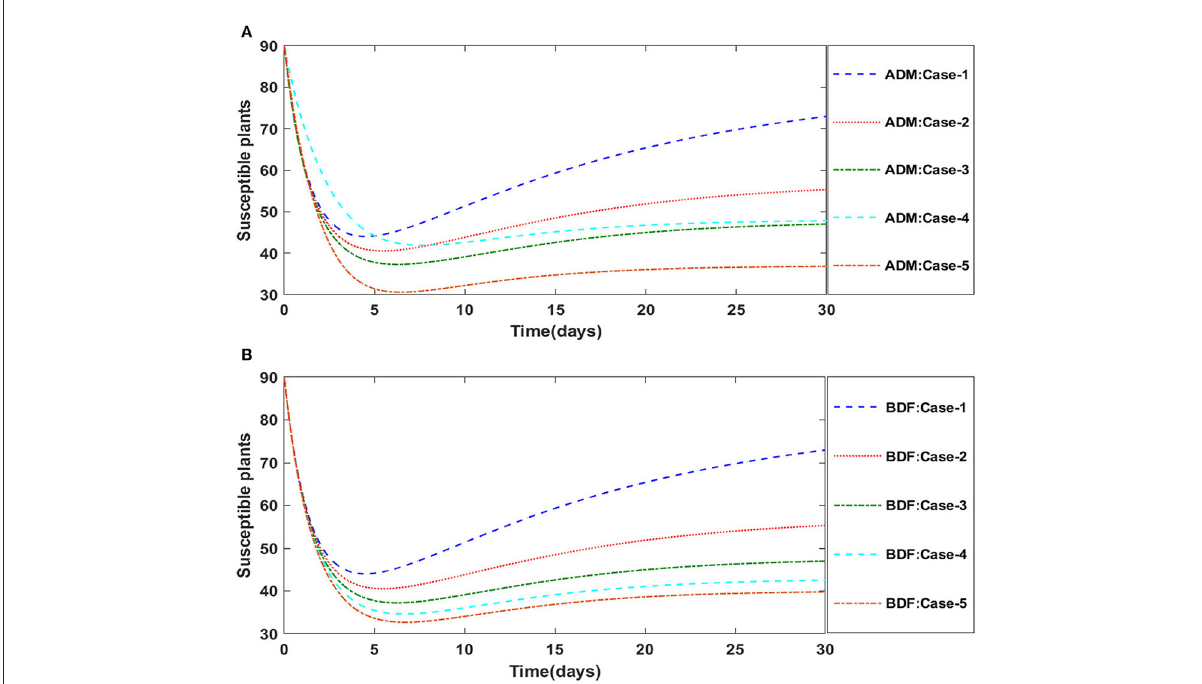
FIGURE2 (A) Dynamics of susceptible plants for the varition in γ 1 using ADM for model A. (B) Dynamics of susceptible plants for the varition in γ 1 using BDF for model A.